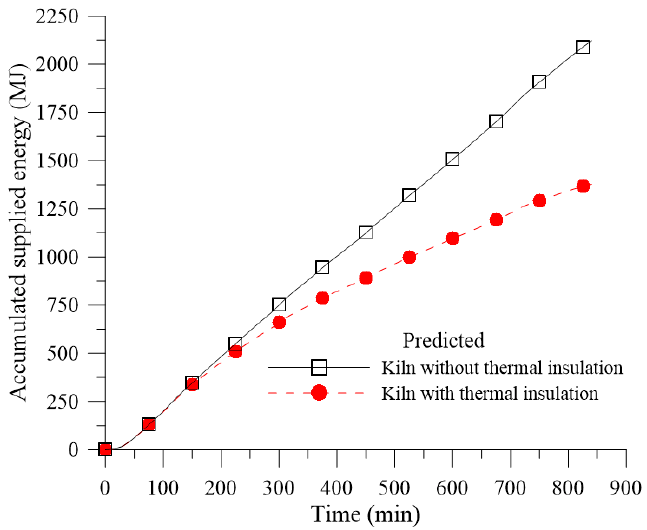
Figure 27. Accumulated energy supplied for the kiln with and without thermal insulation as a function of time.